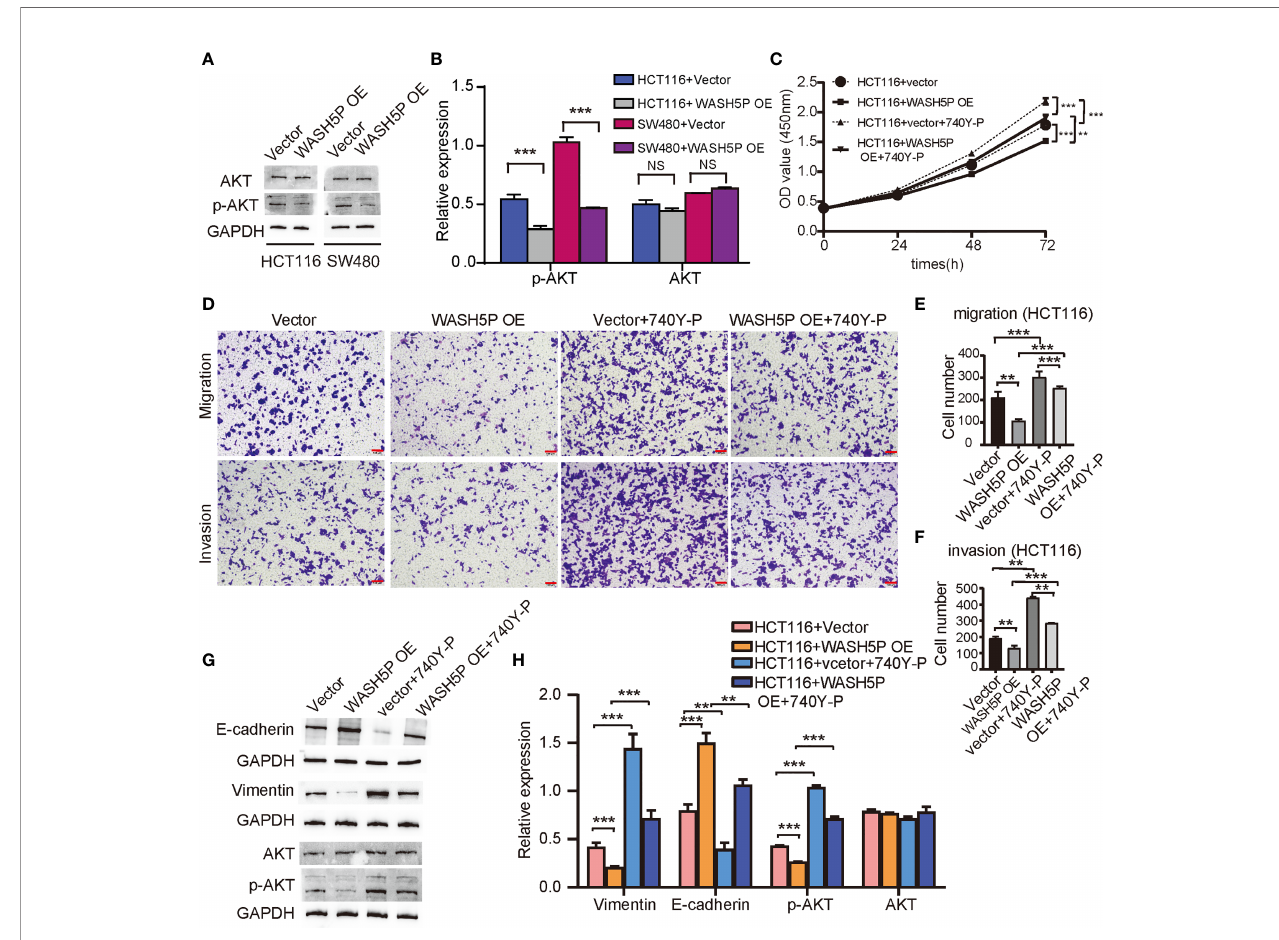
FIGURE 3 | LncRNA WASH5P plays an essential role in inhibiting the development of CRC through the AKT pathway. (A, B) Western blot analysis and summarized data showed that the expression of p-AKT was downregulated in HCT116 and SW480 cells transfected with lncRNA WASH5P compared with a vector. ***. Correlation is signi fi cant at the 0.001 level. (C) CCK-8 assay was performed in HCT116 cells transfected with lncRNA WASH5P or vector. 740Y-P was added to the medium and cultured for 24 h. Cell viability was measured from an absorbance reading at 450 nm. Data were expressed as relative viability (%) calculated: [A450(treated)-A450 (blank)]. **. Correlation is signi fi cant at the 0.01 level, ***. Correlation is signi fi cant at the 0.001 level. (D – F) Transwell Matrigel invasion assays and Migration assays were performed in HCT116 cells transfected with different viruses as indicated. Cells were observed under a light microscope and photographed. Cells were counted from fi ve random microscopic fi elds (×200) per insert in triplicate. The migrated cell numbers were normalized to that of the control group. Data are shown as mean ± SD from three separate experiments. **. Correlation is signi fi cant at the 0.01 level, ***. Correlation is signi fi cant at the 0.001 level. Scale bars represent 100 µm. (G, H) Immunoblots and summarized data showed the expression of AKT, p-AKT, epithelial marker (E-cadherin), and mesenchymal marker (vimentin) in shWASH5P or shNC transfected HCT116 cells after 740Y-P treatment. GAPDH was used as a loading control. Data are shown as mean ± SD from three separate experiments. **. Correlation is signi fi cant at the 0.01 level, ***. Correlation is signi fi cant at the 0.001